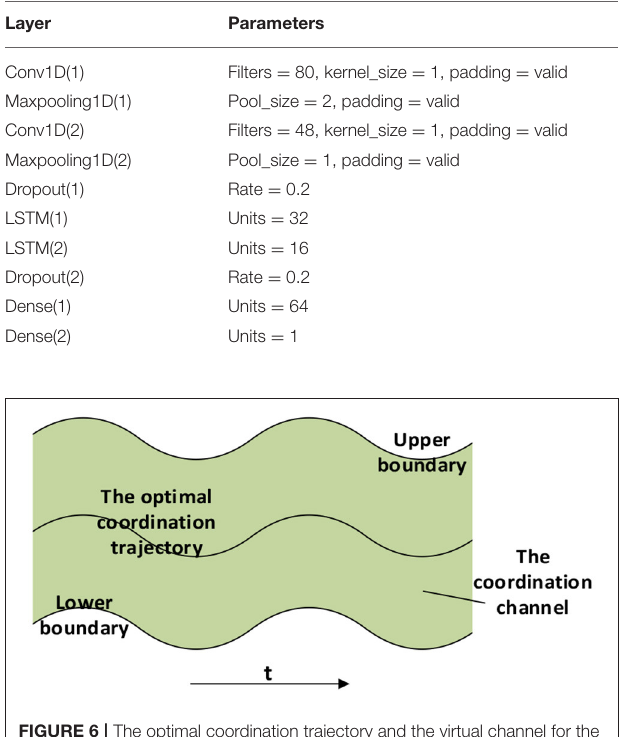
coordination of the shoulder, elbow, and wrist can be